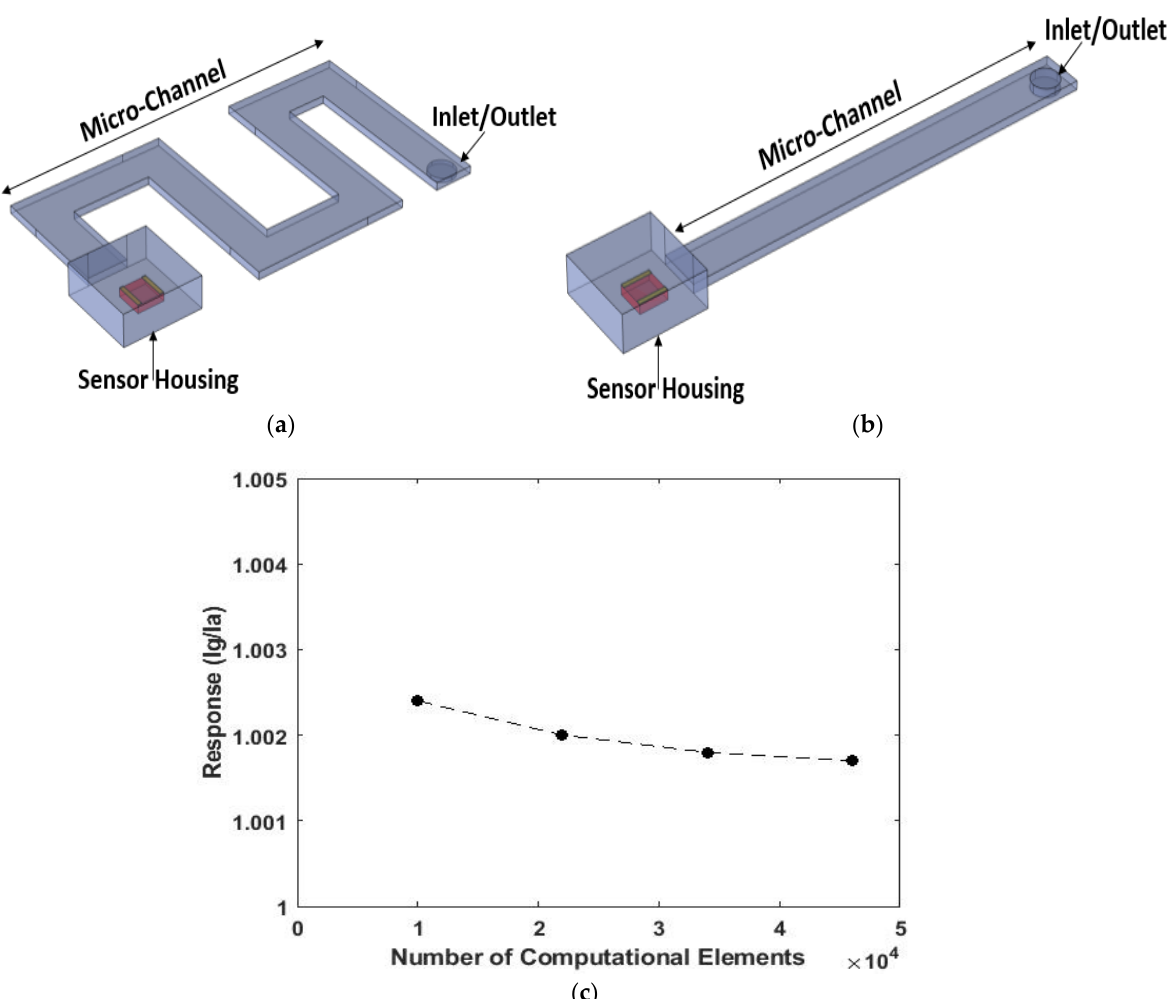
Figure 1. Schematics of the ( a ) serpentine and ( b ) simple simulations. In each model, the gas inlet/outlet, microchannel and sensor housing are specified. ( c ) Result of the mesh independency analysis.